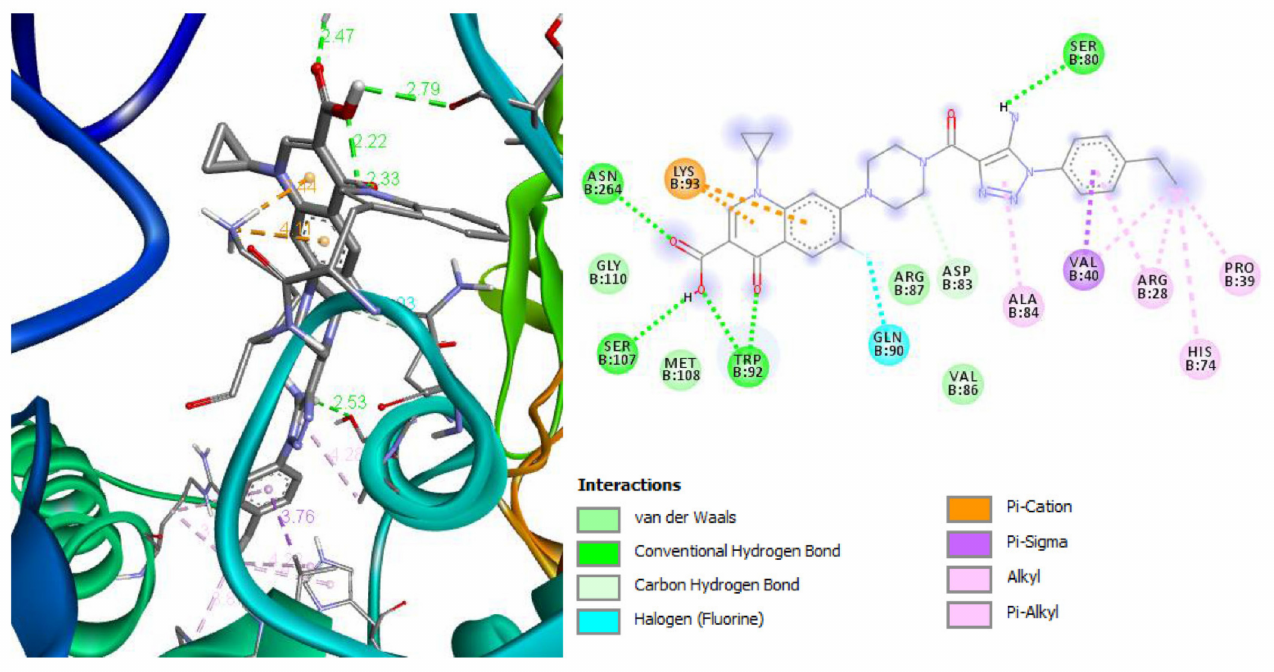
Figure 7. Superposition of molecule 2f and diagram of intermolecular interactions in complex with topoisomerase IV Streptococcus pneumoniae (PDB ID: